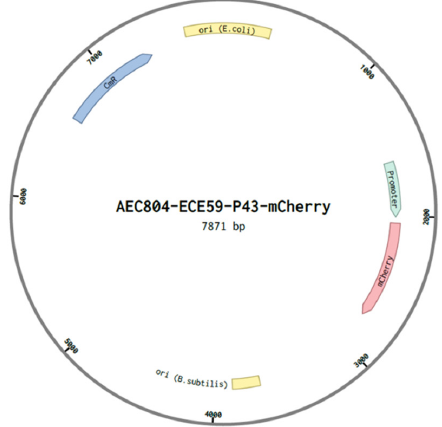
Figure 9. AEC804-ECE59-P43-mCherry plasmid illustration. A shuttle plasmid capable of propagate in both E. coli and B. subtilis via specific origin of replication for each of the bacteria (ORI, in yellow). The plasmid encodes for the fluorescent protein mCherry (in pink), and for Chloramphenicol resistance gene (CmR, in